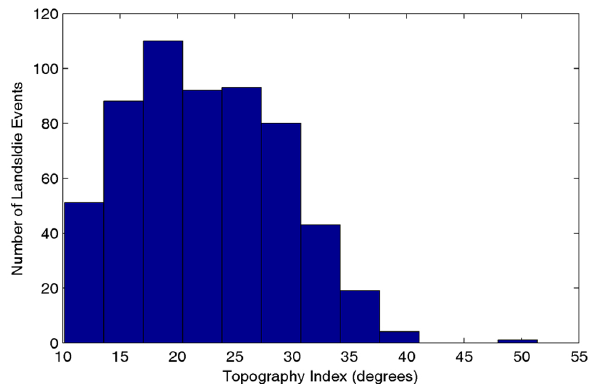
FarahmandandAghaKouchak: ASatellite-BasedGlobalLandslideModel 13 Fig. 6. Distribution of landslides in the four recategorized land cover Fig. 4. Histogram of topography index for landslide observations Fig. 4. Histogram of Topography Fig. 6. Distribution of landslides in the four re-categorized land cover classes. Index for landslide observations based on 250m Digital Elevation Model (DEM). classes. based on 250m digital elevation model (DEM).